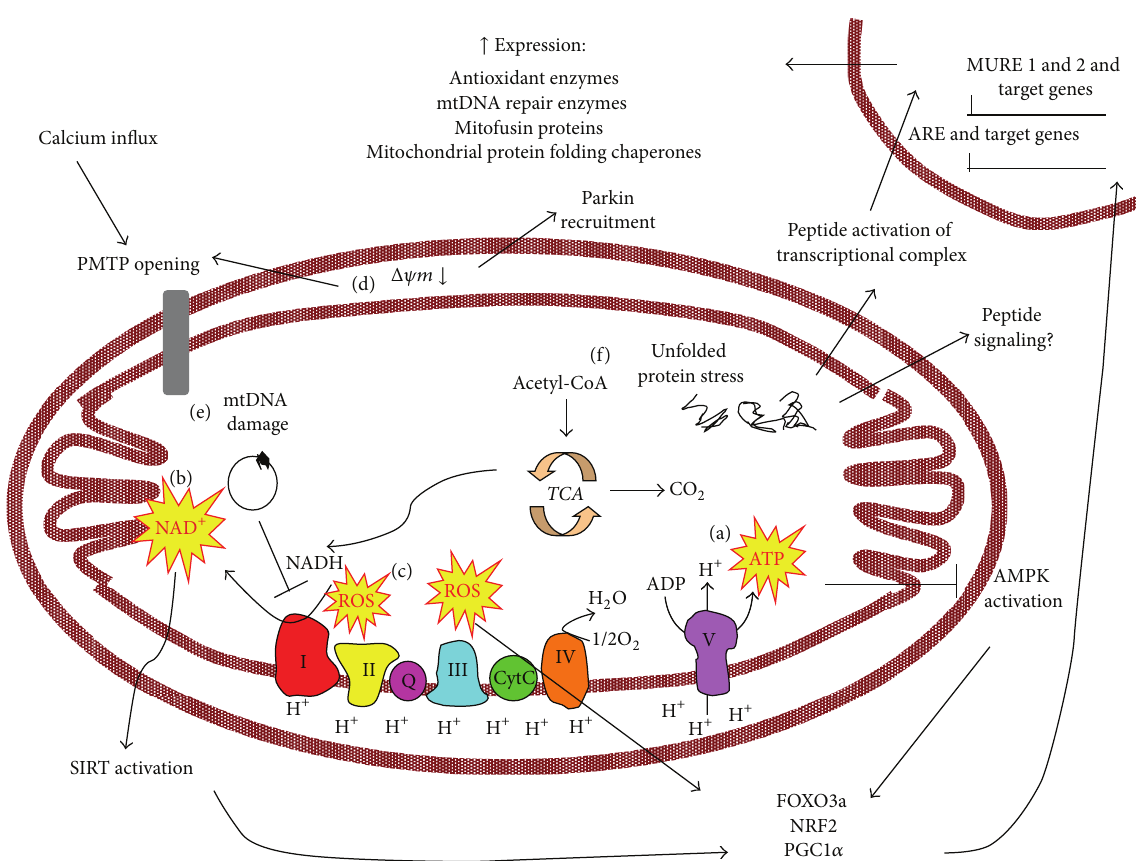
Figure 2: Schematic summary of mitochondrial stress signaling and cellular adaptations. ATP (a), NAD + (b), and ROS (c) are outputs of the electron transport chain and oxidative phosphorylation that may function as stress signals. NAD + can activate sirtuins (SIRT) and increased AMP/ATP ration can activate AMPK, which activate transcription of antioxidant defences, mitochondrial DNA repair enzymes, and other target genes important in mitochondrial biogenesis and metabolism through transcription factors FOXO3a, NRF2, and the transcriptional coactivator PGC1 𝛼 . ROS can also directly activate these transcriptional regulators. Mitochondrial DNA (mtDNA) damage can potentiate oxphos dysfunction (e) and hence lead to the above responses. Loss of innermitochondrial membrane potential (d) can lead to PMTP opening or parkin recruitment and hence mitophagy. Through peptide export, unfolded protein stress (f) can activate a transcriptional complex which acts on the MURE1, MURE2, and CHOP elements to induce the transcription of mitochondrial protein folding